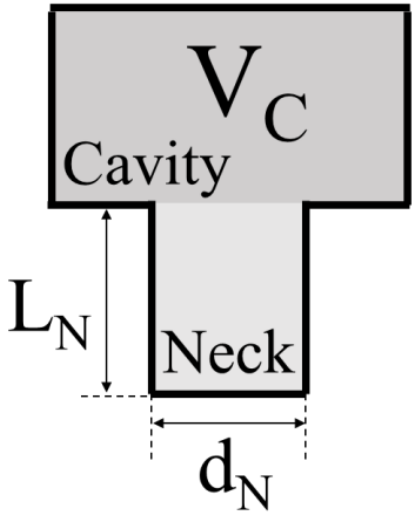
Figure 6. Helmholtz resonator layout.